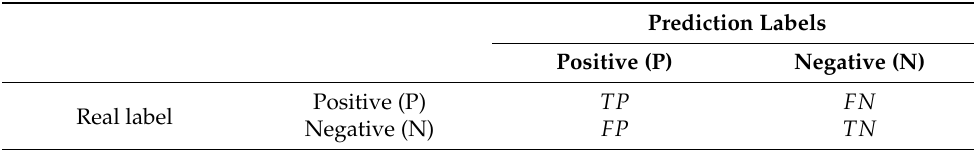
Table 3. Confusion matrix for PD speech recognition